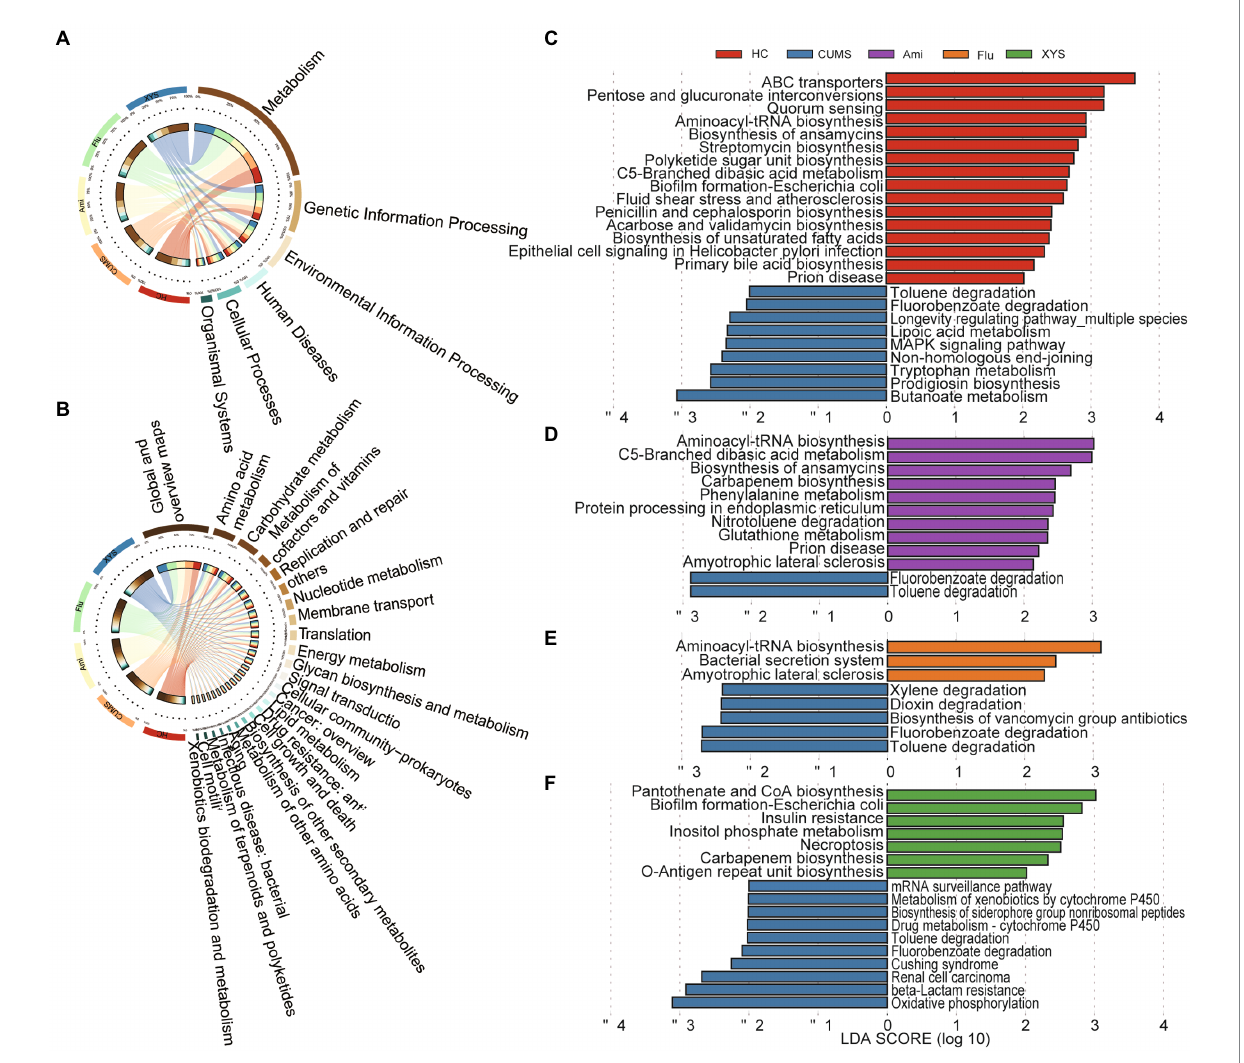
FIGURE 3 The functional profiles of gut virome in the KEGG pathway via metagenomics sequencing. Distribution of KEGG pathways at (A) level 1 and (B) level 2. LEfSe analysis of the KEGG pathways with the criteria of LDA > 2.0. (C) Comparison between the HC and CUMS on the level 3 of KEGG pathways. (D) Comparison between the CUMS and Ami on the level 3 of KEGG pathways. (E) Comparison between the CUMS and Flu on the level 3 of KEGG pathways. (F) Comparison between the CUMS and XYS on the level 3 of KEGG